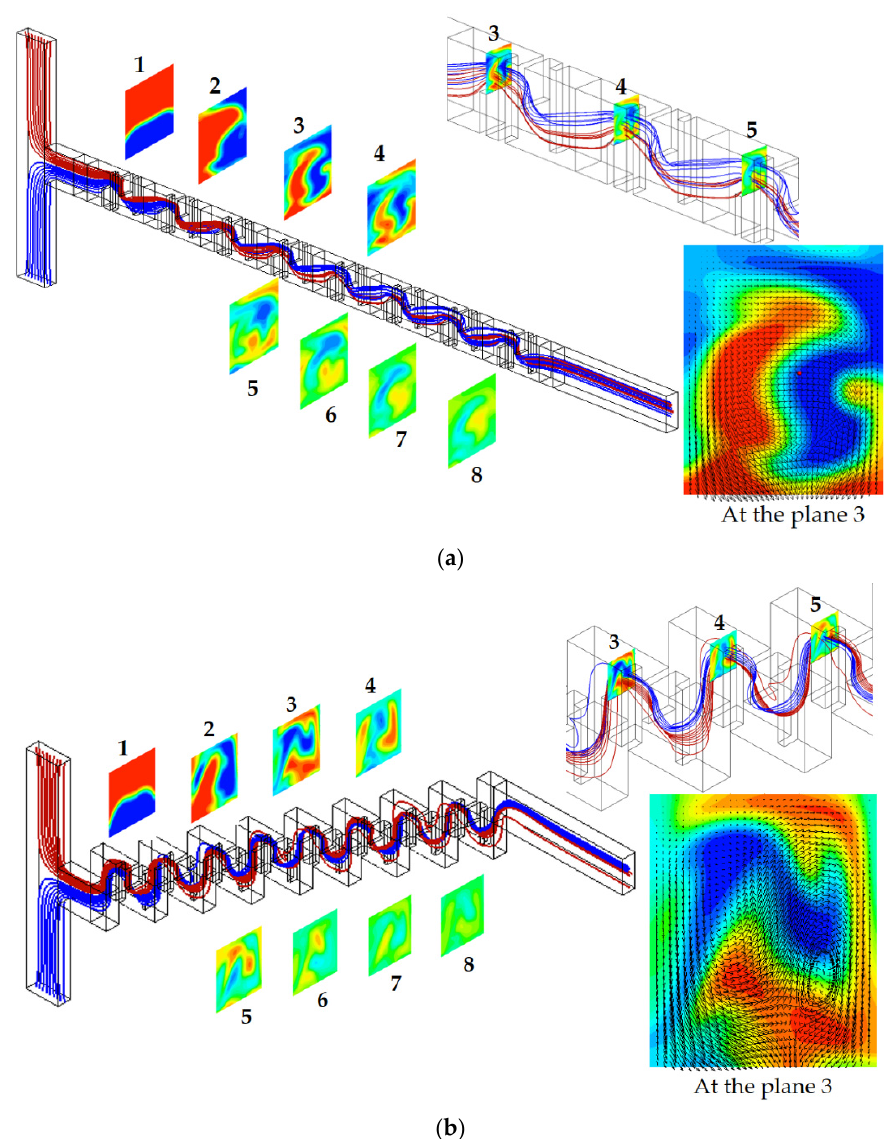
Figure 12. Streamlines starting from the two inlets and concentration contours at the plane of the first baffle within each mixing unit for Re = 20. ( a ) Baseline. ( b ) Eight step stacking.